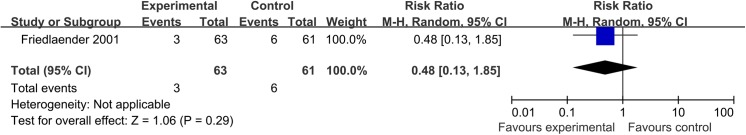
Forest plot of revision rate of tibial nonunion treated with BMP versus control group.